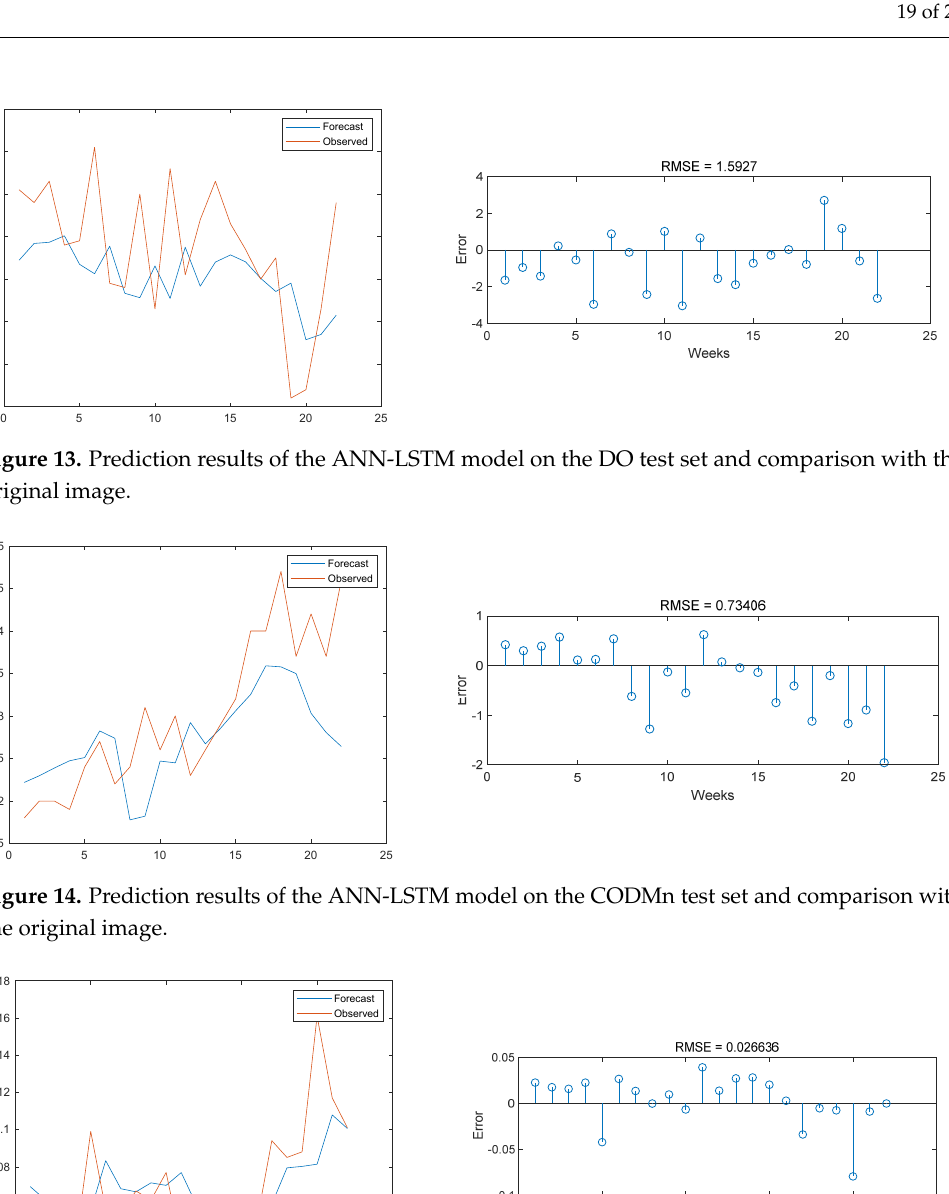
Figure 12. Prediction results and error images of the ANN-WT-LSTM model for high-frequency and low-frequency parts of the NH3-N verification set.